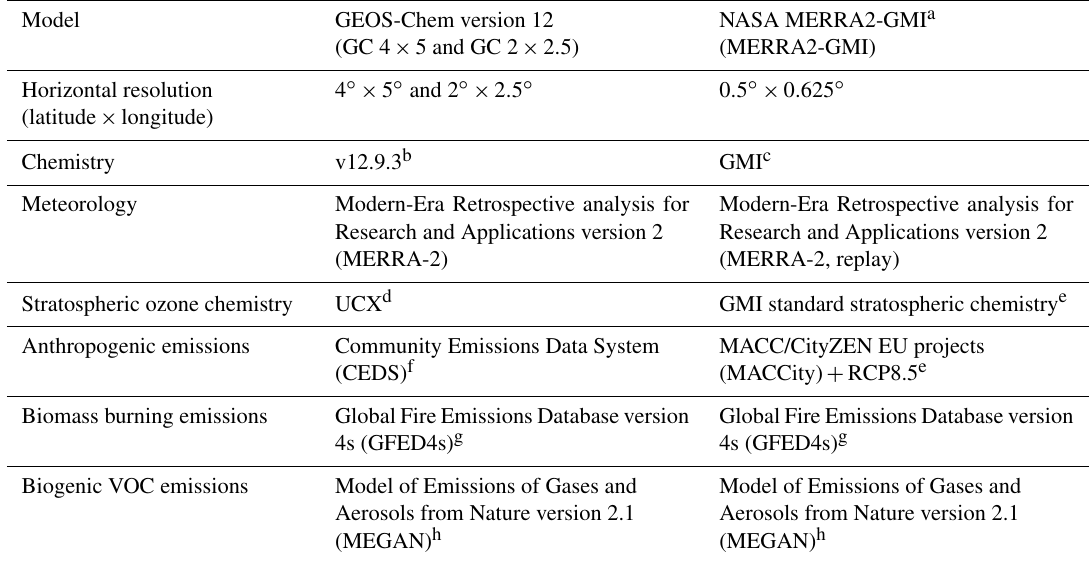
Table 2. Description of three simulations with GEOS-Chem version 12 (two simulations at different resolution; GC 4 × 5 and GC 2 × 2 . 5) and